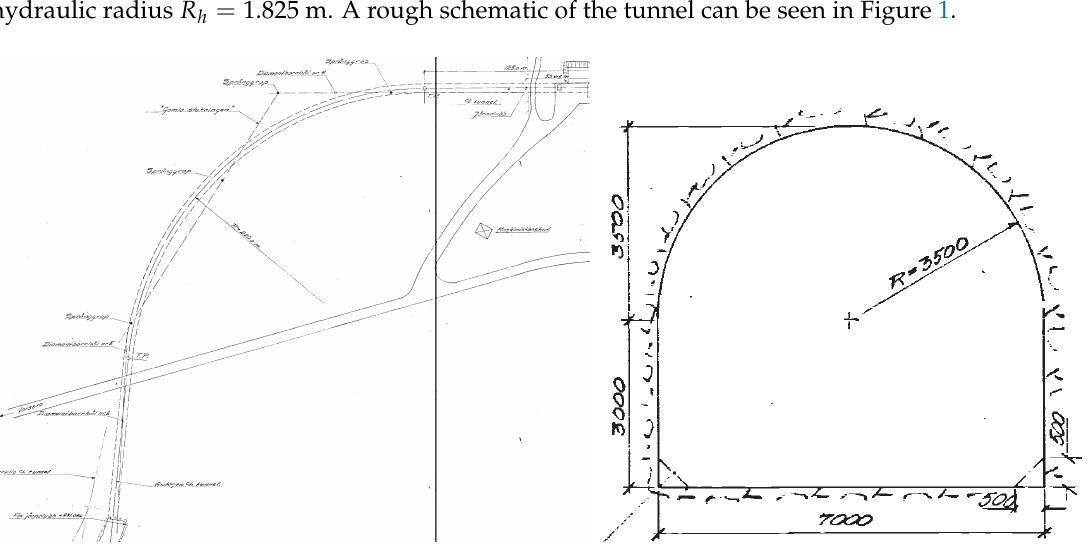
Figure 1. A top-view ( left ) and cut-through ( right ) schematic of the tunnel, both drawings made pre-excavation. The flow is from right to left according to the left figure. Units are given in